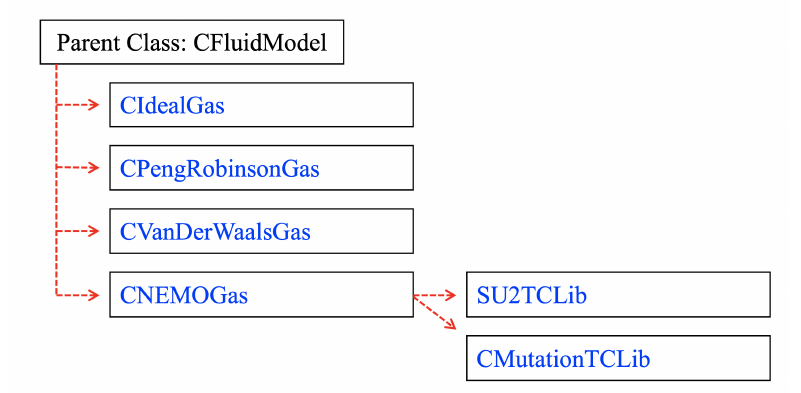
Figure 3. SU2 CFluidModel with CNEMOGas, with native and Mutation++ thermochemical libraries as child